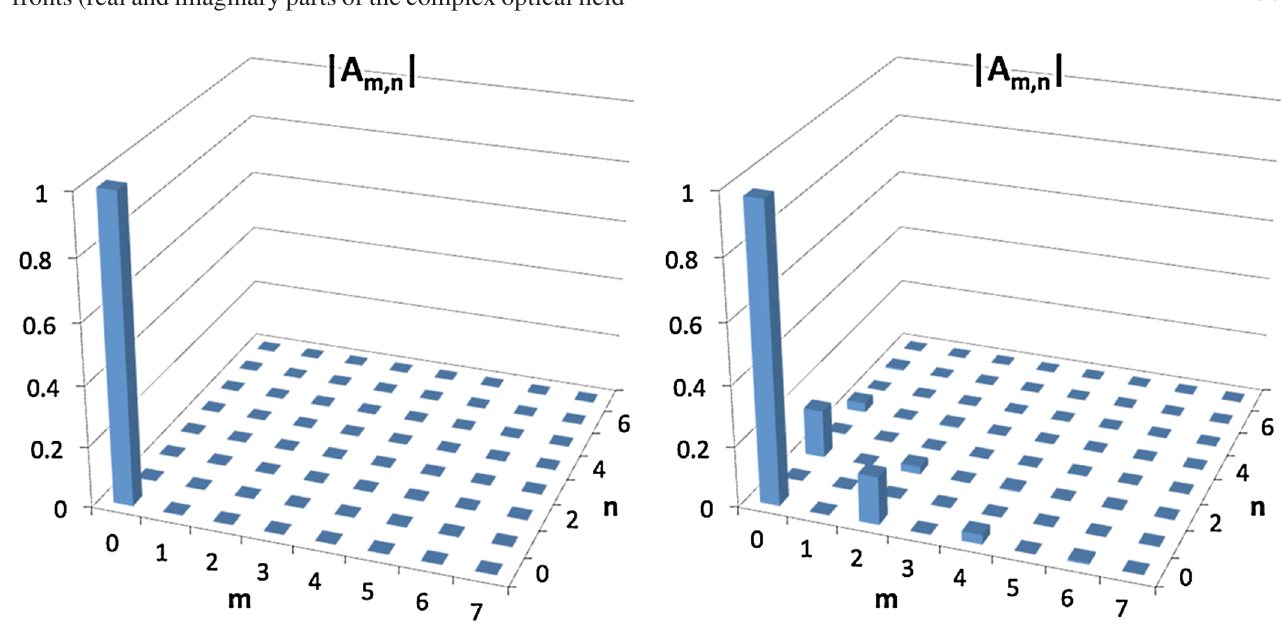
FIG. 1. (Color) Modal composition histogram of a purely (0,0) mode (coefficient area ¼ 1 : 0 ) against the correct basis, (cid:1) ¼ 1 : 25 and (cid:2) ¼ 4 : 0252 (left) and a different scaling factor, (cid:2) ¼ 3 : 0 , resulting in a coefficient area ¼ 1 : 06 and finding 94.7% in the (0,0) mode and (cid:5) 2 : 5% in the (0,2) and (2,0) modes (right). Histograms are plotted as j C m;n j to better show the higher-order modes, using the color scale shown on the